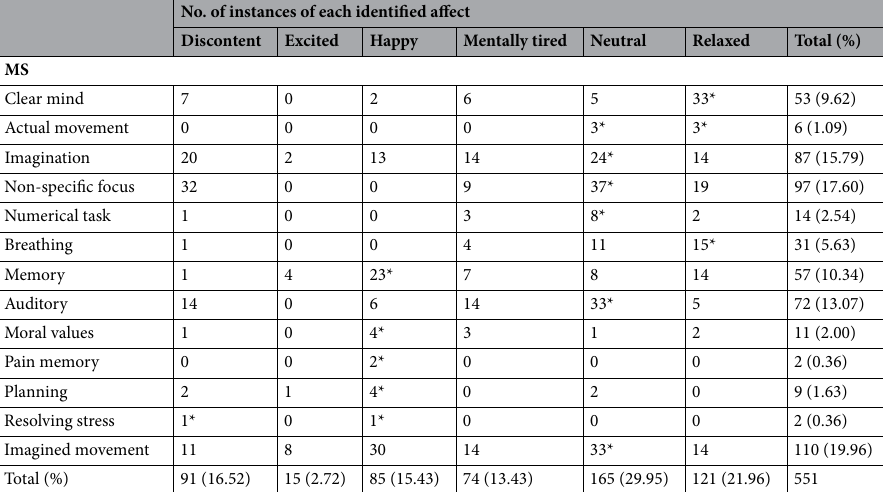
Table 7. Matching mental strategy with affect. *The most associated affect for each mental strategy. MS No. of instances of each identified mental